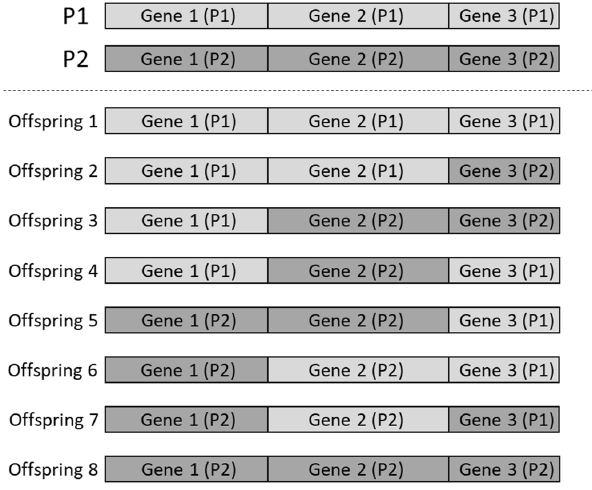
parent combinations